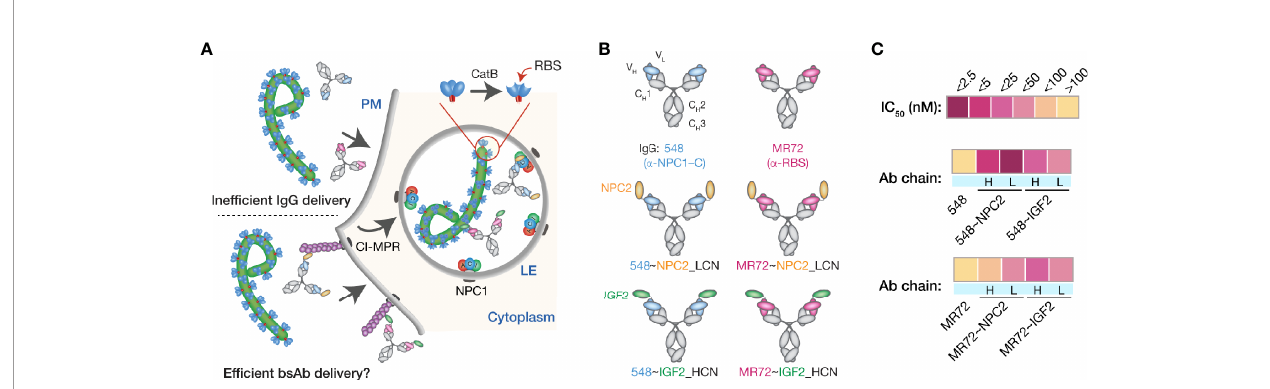
FIGURE 1 | Design and initial evaluation of bispeci fi c antibodies combining CI-MPR ligands and mAbs blocking the endo/lysosomal fi lovirus GP:NPC1 interaction. (A) A hypothetical mechanism for delivery of NPC2- and IGF2-tagged bsAbs (bottom) but not parental mAbs (top) to sites of GP CL :NPC1 interaction in late endosomal/lysosomal (LE) compartments. (B) Schematic representations of a subset of the antibodies tested in this study. Top row: parental mAbs, NPC1 domain C (NPC1 – C)-speci fi c mAb-548 and viral glycoprotein receptor-binding site (RBS)-speci fi c mAb MR72. Middle row: NPC2-tagged bsAbs. NPC2 was fused to the N – terminus of the light chain (LCN) of mAb-548 and MR72. Bottom row: IGF2-tagged bsAbs. IGF2 was fused to the N – terminus of the heavy chain (HCN) of mAb-548 and MR72. (C) Heat map showing neutralizing IC 50 values against rVSV-EBOV GP for the antibody panel. For curves that did not cross the 50% threshold, IC 50 values were considered >100